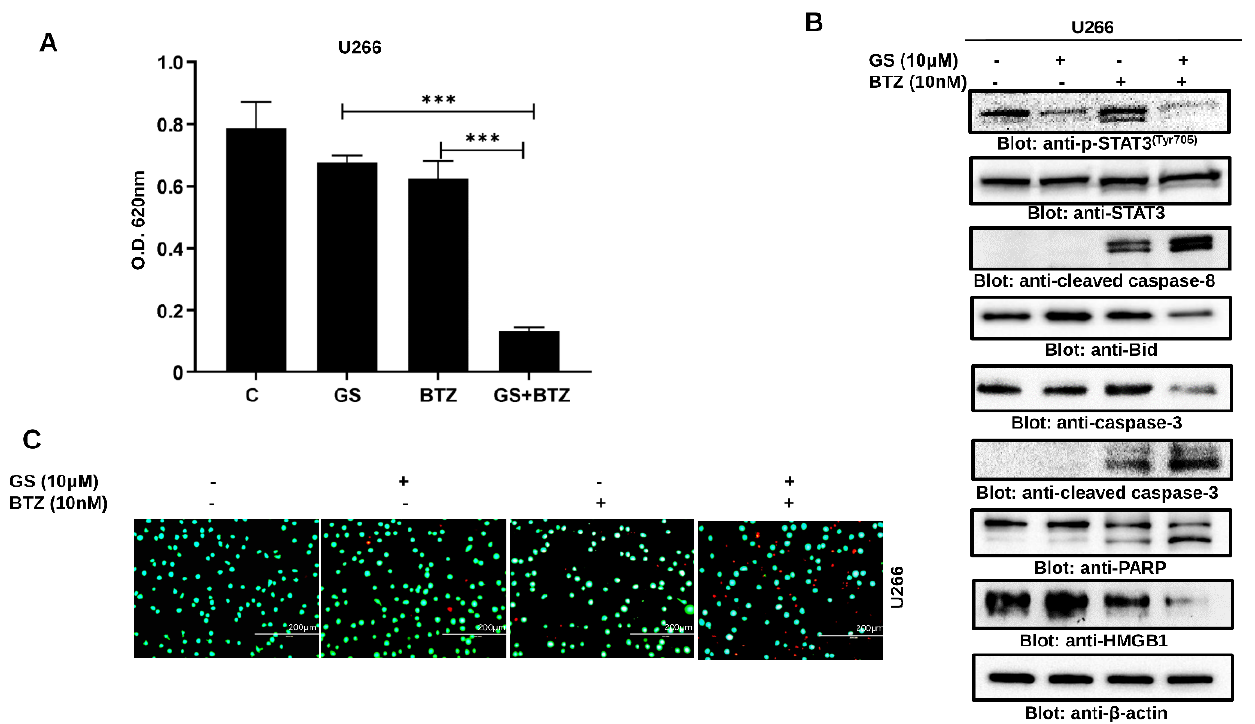
Figure 8. GS sensitizes MM cells to BTZ. U266 cells were incubated with 10 µ M of GS and 10 nM of BTZ alone or in combination for 48 h. ( A ) The bar graph displays the cell viability determined by CCK-8 analysis. Data is presented as mean ± SD (n = 6. *** p < 0.0001). ( B ) The GS and BTZ- treated cells were lysed, and protein expressions of p-STAT3, STAT3, cleaved caspase-8, Bid, caspase-3, cleaved caspase-3, PARP, HMGB1, and β -actin were determined. ( C ) Cell viability using a live/dead cytotoxicity kit was also assessed (Scale bar, 200 µ m). Full Western blot images can be found at Supplementary Materials File S1.